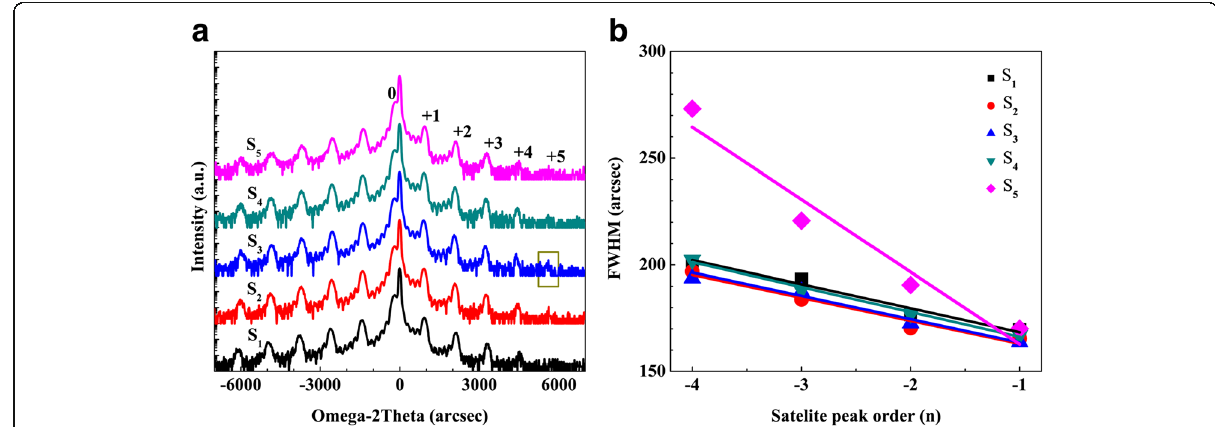
Fig. 1 a The HRXRD ω -2 θ scanning results of S 1 – S 5 . b The FWHM as a function of the satellite peak order and its linear fitting for the five